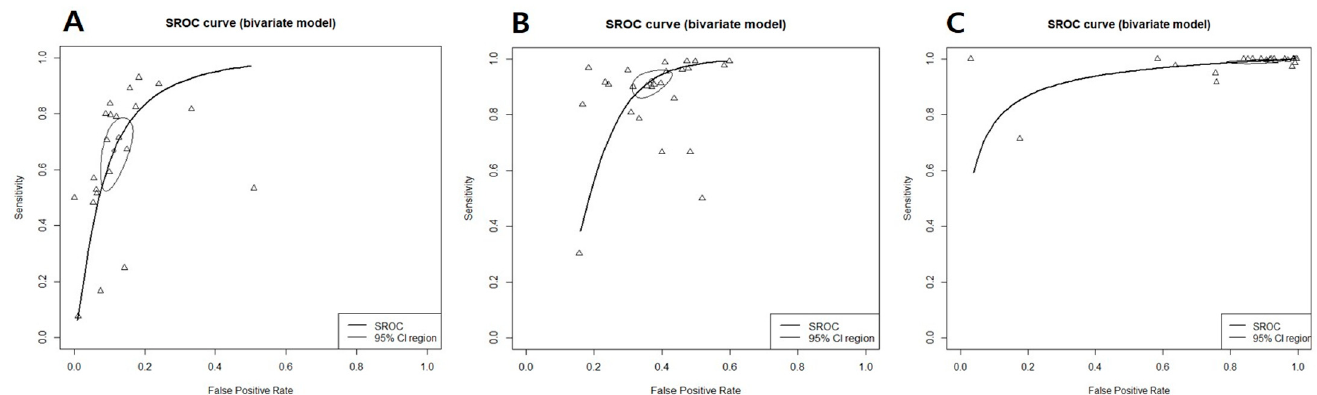
Figure 3. Summary receiver operating characteristic curve for K-TIRAD. ( A ) High (K-TIRADS 5), ( B ) intermediate (K-TIRADS 4), ( C ) low (K-TIRADS 3), thick curved line: summary receiver operating characteristic curve; thin circular line: 95% confident region; small circle: summary estimate; triangle: observed data.